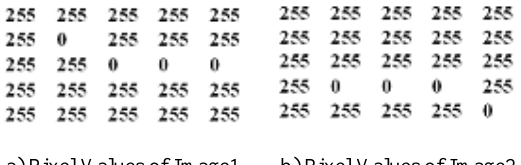
Figure 1. Pixel Values of Images